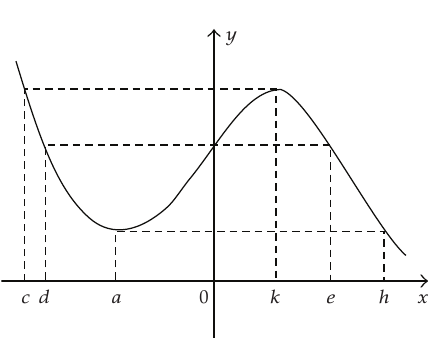
Figure 7: The picture of curve y (cid:2) f (cid:3) x (cid:4) /g (cid:3) x (cid:4) .